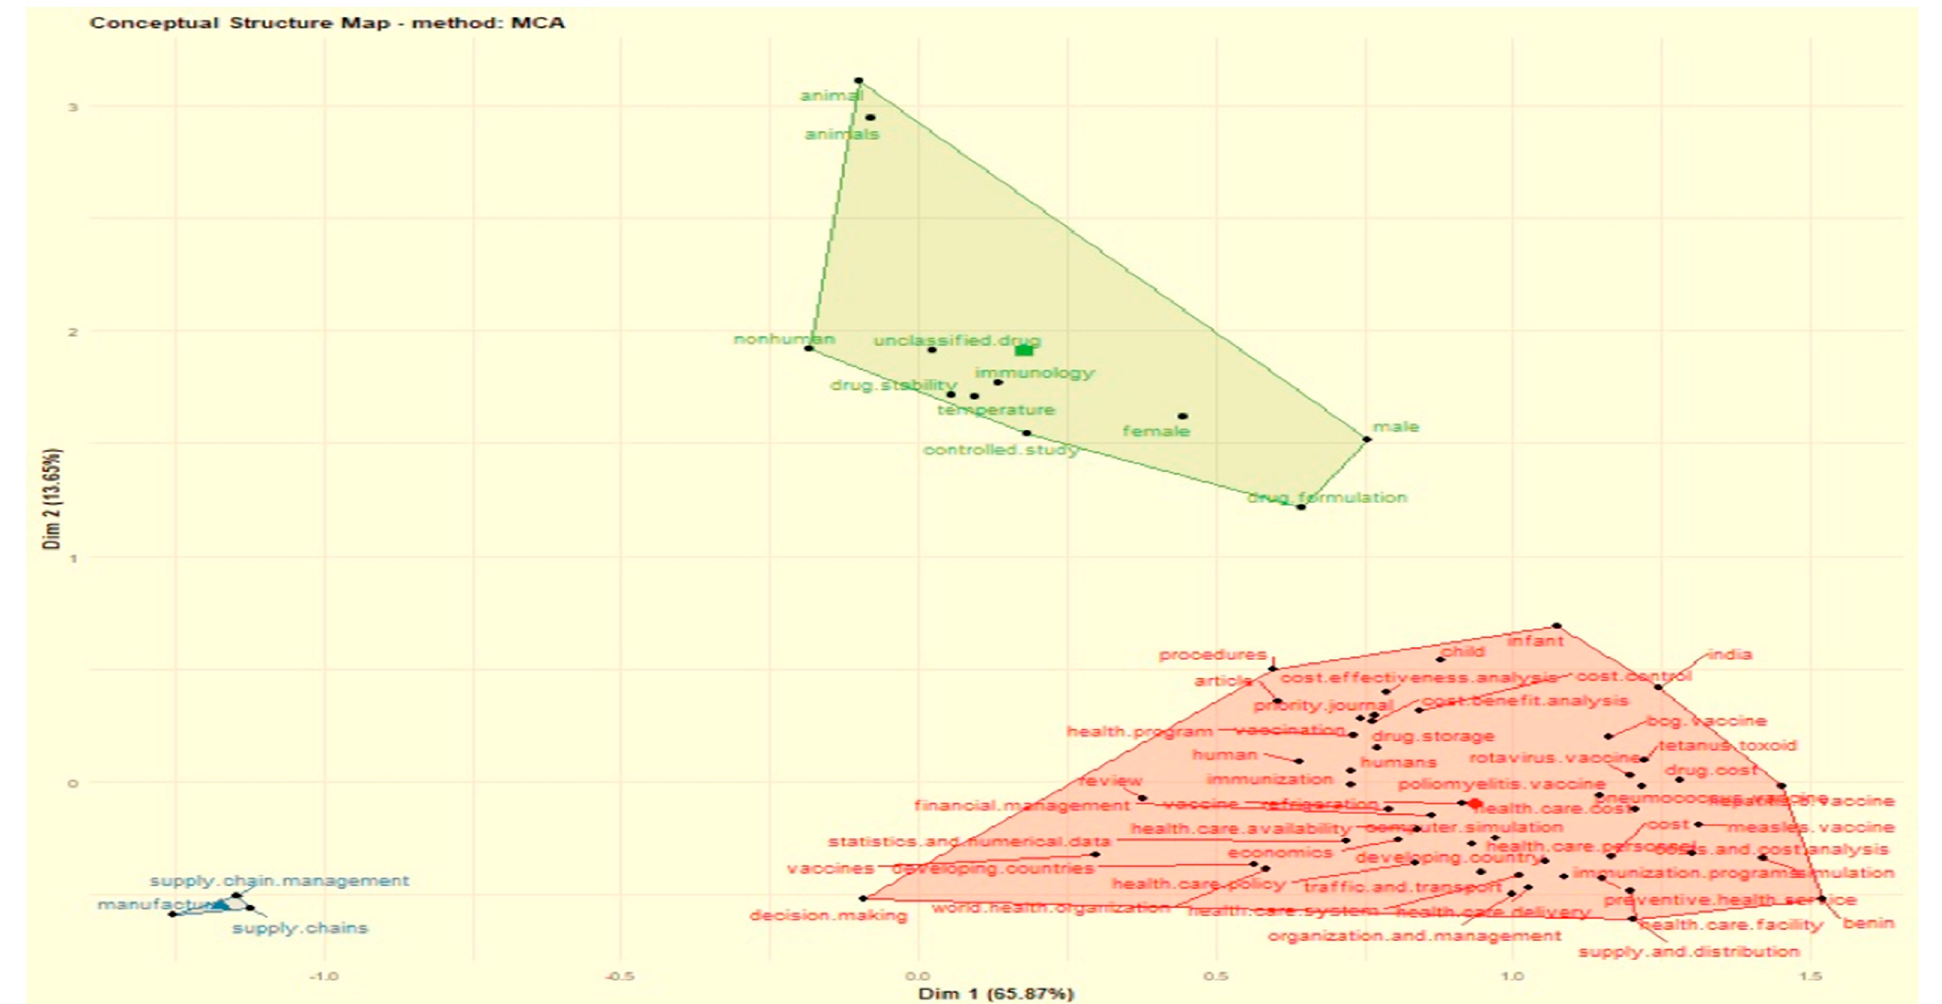
Figure 8. Multiple correspondence analysis of high-frequency keywords in the field of VSCM.